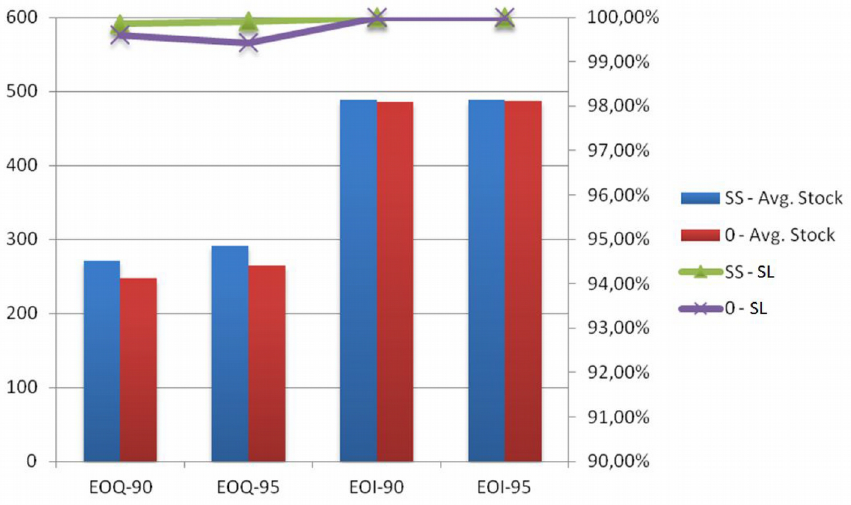
Figure 7. Factorial sub-plan